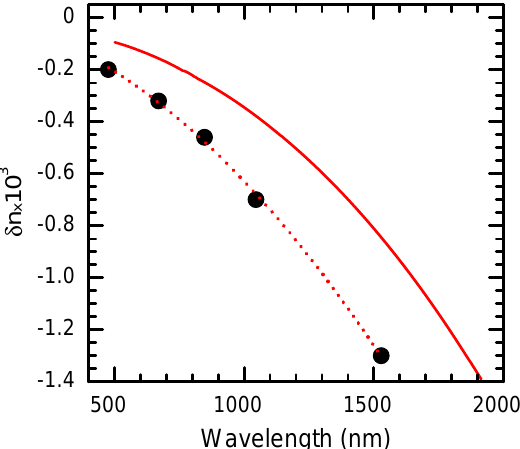
Figure 12. Spectral dependency of the photoinduced change of refractive index of CdF ( N = 4 × 10 17 cm − 3 ) crystal determined at T = 100 K (black circles) and its fit with the Ga two-oscillator model (dotted line). The solid line shows this dependence calculated by the Kramers-Kronig transformation using the photoinduced modification of absorption spectrum of the crystal that is shown in Figure